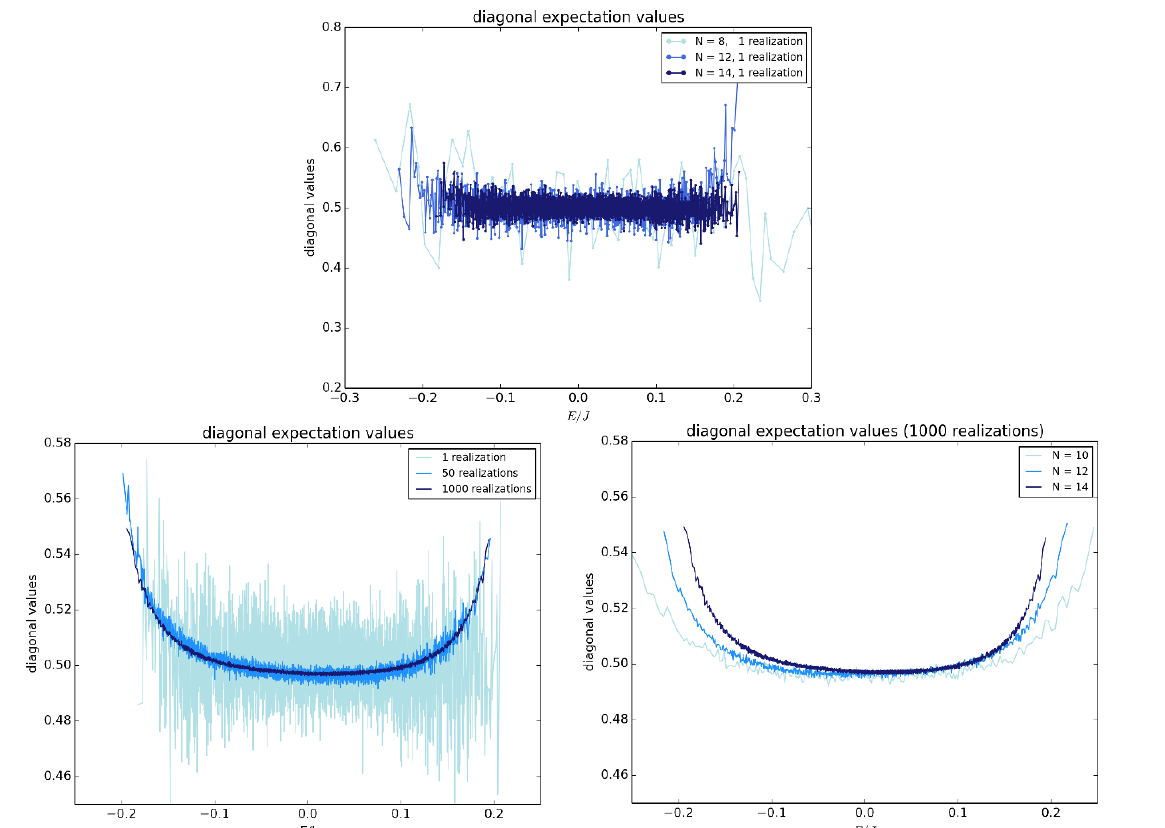
Figure 2 . Diagonal expectation values for the single-site number operator at site N , that is ^ n N at half (cid:12)lling (cid:23) = 1 . Top panel : we show a single random realization for increasing Hilbert space 2 dimension corresponding to N = 8 ; 12 ; 14. We see that the on-diagonal expectation values of a single realization approach closer and closer to a smooth curve. Left panel : we show the e(cid:11)ect of averaging of the random couplings at given (cid:12)xed Hilbert space dimension, N = 14. As expected the on-diagonal values of the ensemble approach closer and closer to a smooth curve. Right panel : we show the limiting curves for the model with (cid:12)xed Hilbert space dimension corresponding to N = 10 ; 12 ; 14, averaged over 1000